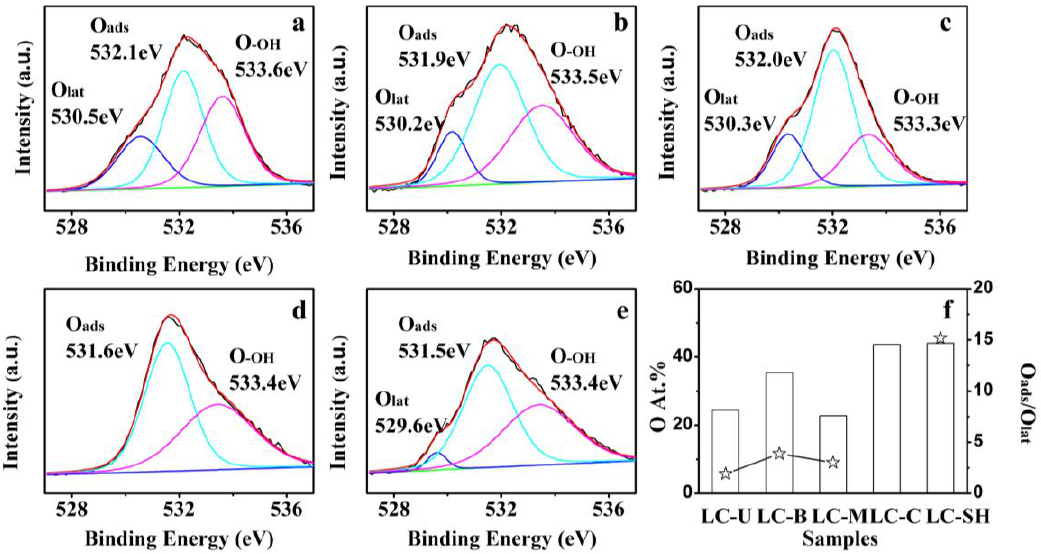
Figure 8. O 1s XPS spectra of catalysts with different nitrogen sources. ( a ) LC-U; (b) LC-B; ( c ) LC-M; ( d ) LC-C; and, ( e ) LC-SH.